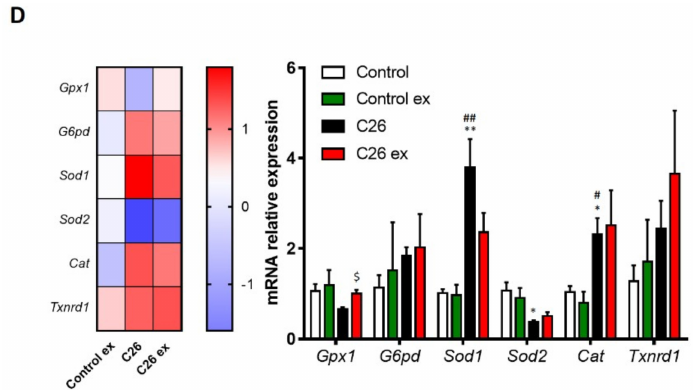
Figure 4. Antioxidant systems are upregulated in both sedentary and exercised tumor-bearing mice. Nrf2 and Keap1 protein levels ( A ; representative blot and quantification), Nrf2/Keap1 ratio ( B ), CuZn SOD and catalase protein levels ( C ; representative blot and quantification) and gene expression of antioxidant enzymes ( D ; heat map and histogram) of control ( n = 5), control exercised (control ex; n = 6) and tumor-bearing mice either sedentary (C26; n = 8) or exercised (C26 ex; n = 8). Protein expression data (means ± SD) are percentage of control values. Nrf2/Keap1 ratio (means ± SD) is expressed as arbitrary units (A.U.). Gene expression data (means ± SEM) are ∆∆ ct and relative expression to control, respectively for heat map and histogram. Significance of the differences: * p < 0.05, ** p < 0.01, *** p < 0.001 vs. control; # p < 0.05, ## p < 0.01 vs. control ex; $ p < 0.05 vs.